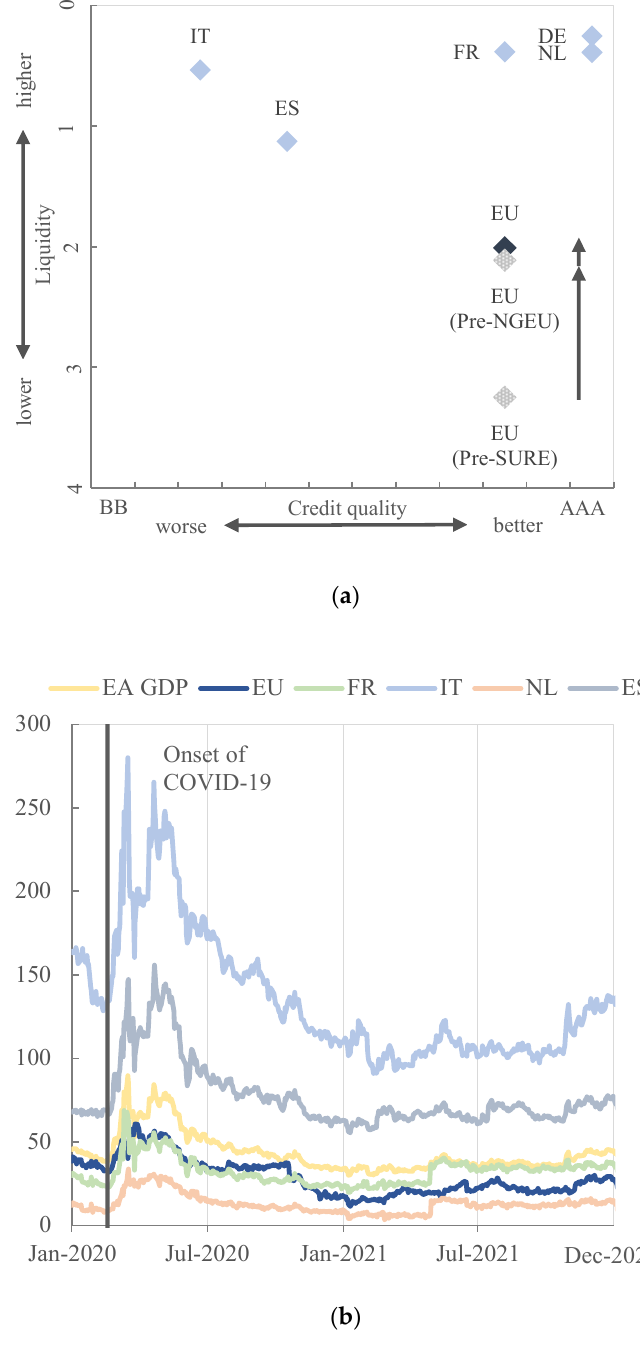
Figure 2. Credit risk indicators for EU bonds. ( a ): Scatterplot of market liquidity (average bid–ask spreads in basis points) vs. credit quality (minimum rating). Arrow origins refer to September 2020 (“Pre-SURE”) and May 2021 (“Pre-NGEU”). Arrow endpoints and all other diamonds refer to October 2021 (Post-NGEU’s first auction). Higher liquidity corresponds to tighter bid–ask spreads. The rating score on the horizontal axis is calculated from minimum issuer ratings across S&P, Moody’s, Fitch, and DBRS. ( b ): Ten-year yield spreads over German Bunds, in bps, between January 2020 and December